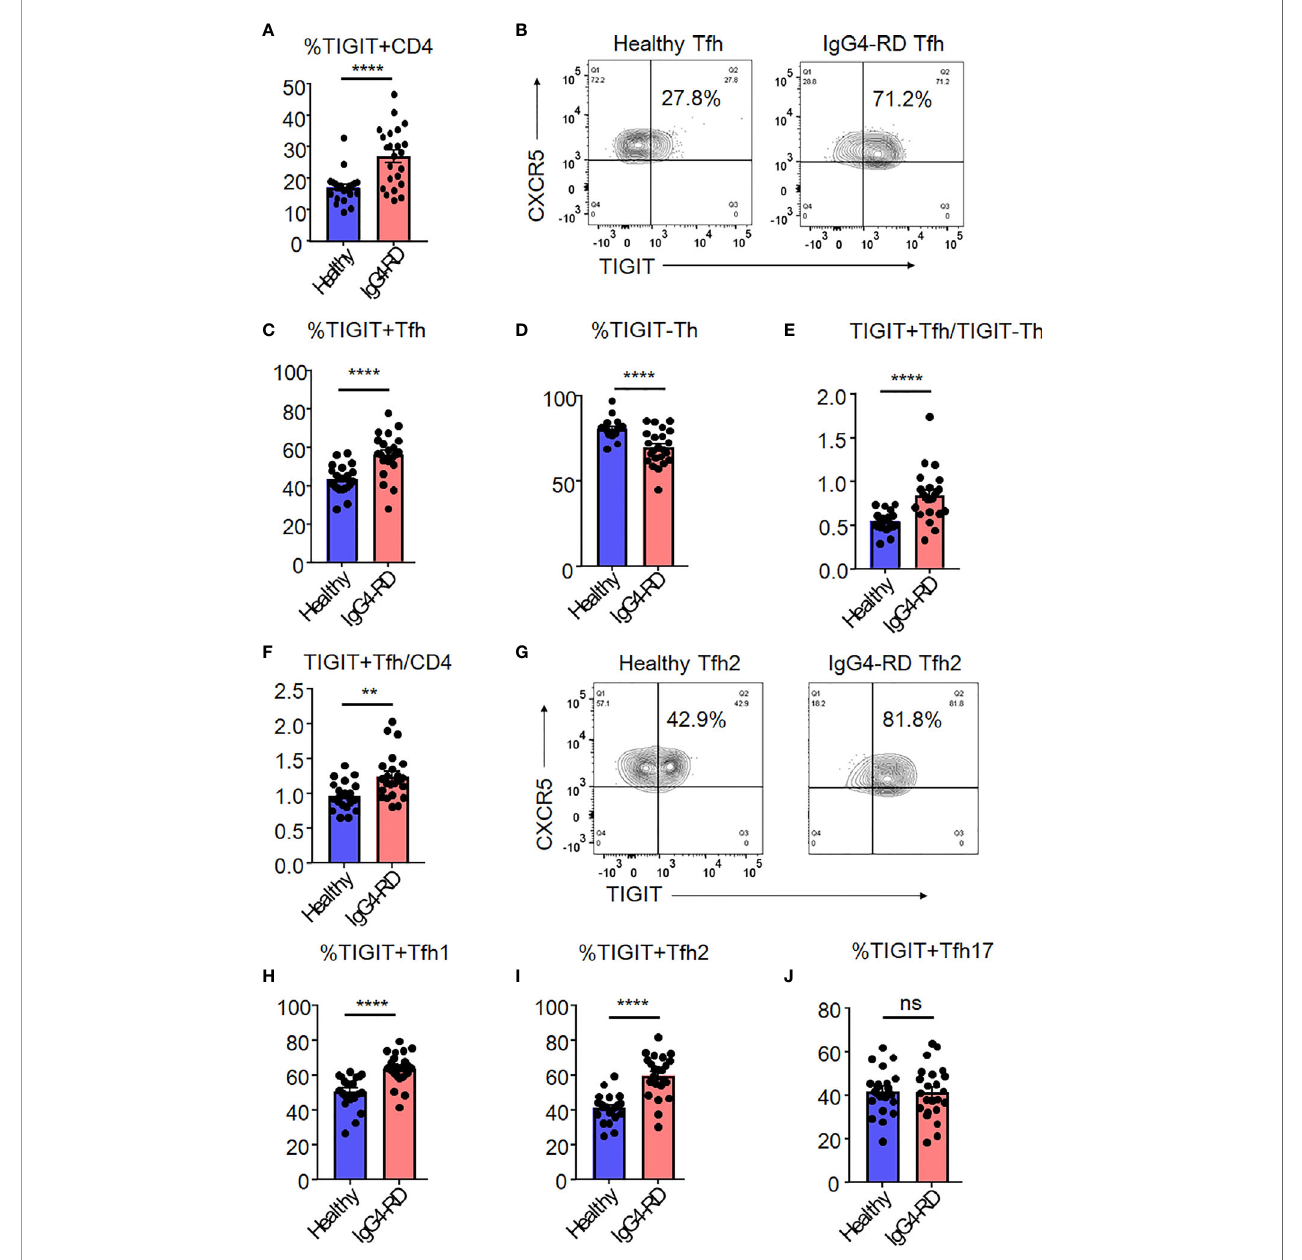
FIGURE 7 | The increase of TIGIT + Tfh cells in IgG4-RD. The proportion of TIGIT + CD4 + T cells (A) , TIGIT + Tfh cells (B, C) , TIGIT - Th cells (D) , the ratio of TIGIT + Tfh to TIGIT - Th cells (E) , and the ratio of TIGIT + Tfh to CD4 + T cells (F) were examined in blood from patients with untreated, active IgG4-RD (n=23) or healthy individuals (n=21). The proportion of TIGIT + Tfh1 (H) , TIGIT + Tfh2 (G, I) , and TIGIT + Tfh17 (J) cells was analyzed and compared. (A, C – F, H – J) unpaired t test. ****p<0.0001, **p<0.01, ns